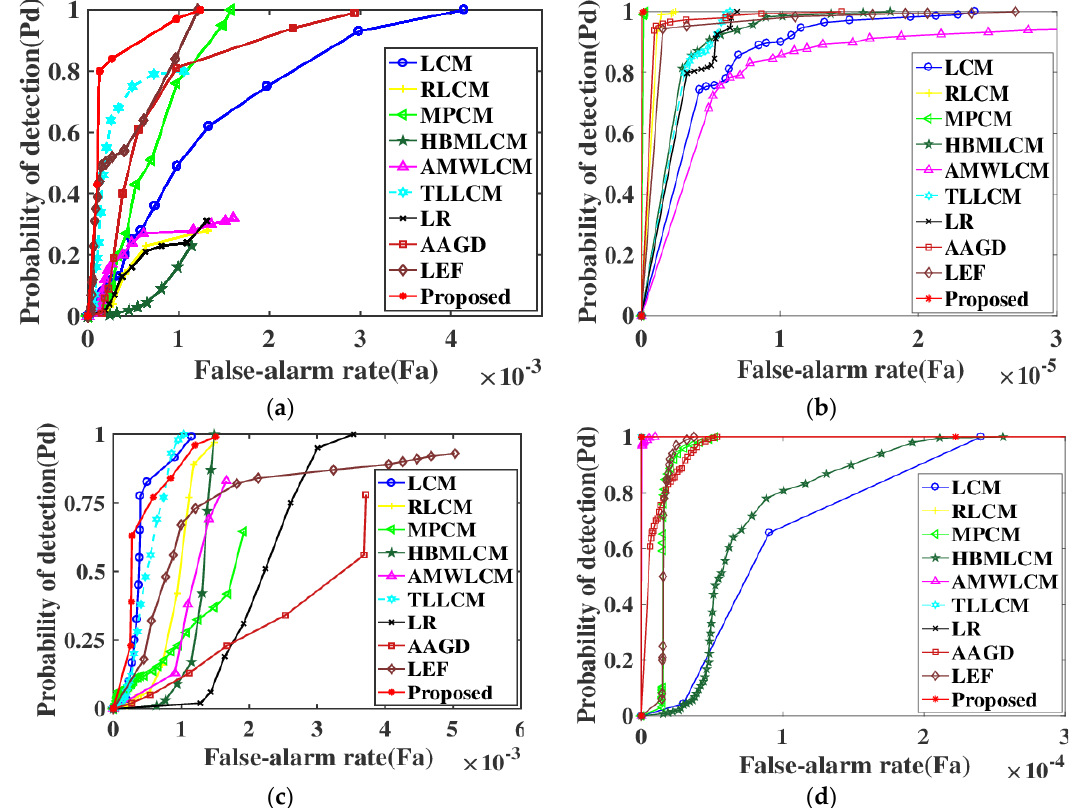
Figure 6. ROC curves of different methods: ( a – d ) Roc curves of Seq. 1 – 4.